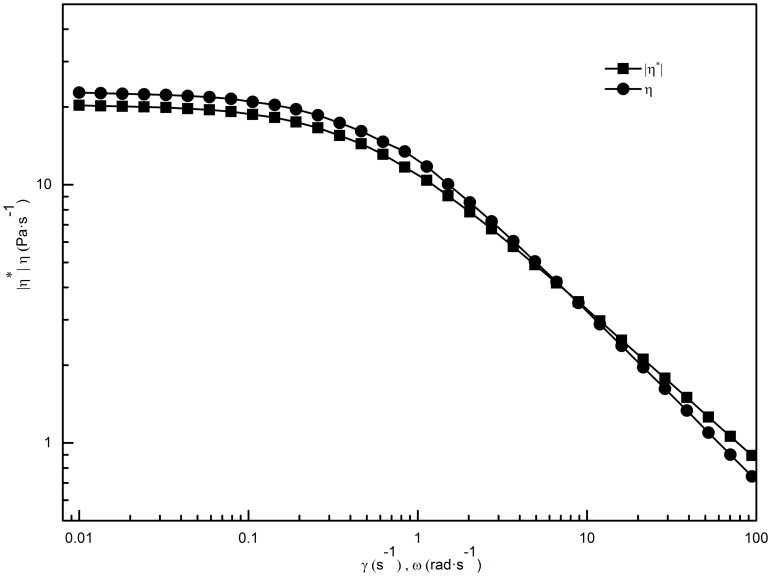
Shear-rate dependence of the steady-shear viscosity and frequency dependence of the complex viscosity for 70 mM C16MPBr/30 mM SL solution.